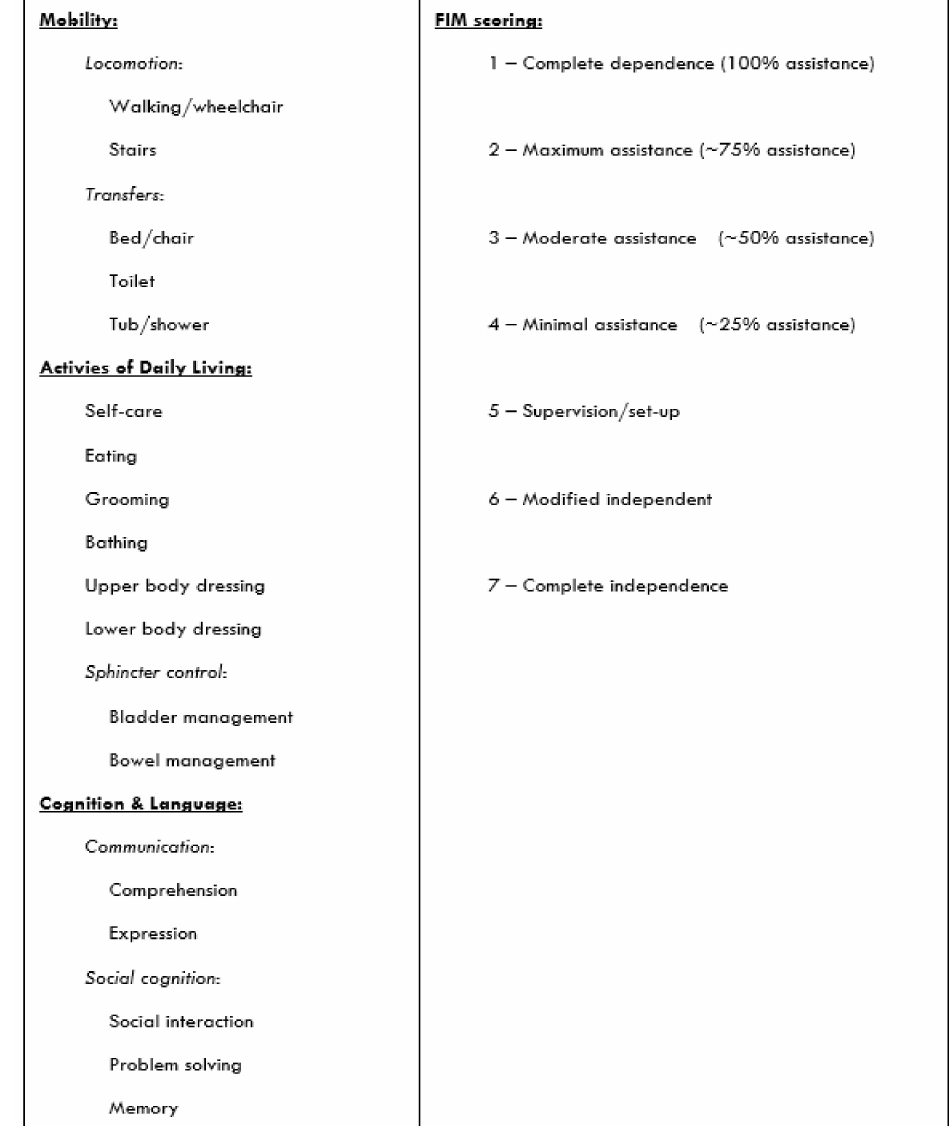
Figure 1. Functional Independence